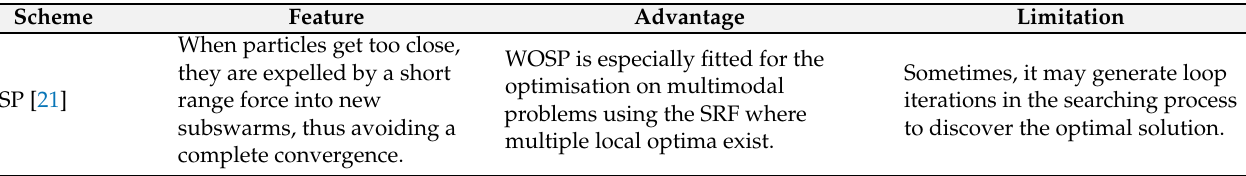
Table 2. Feature comparisons of three known MSPSO